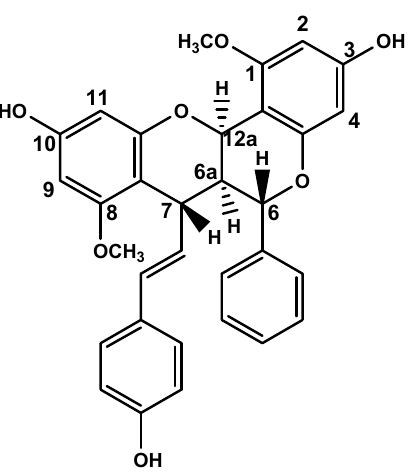
Figure 1. Chemical structure from the Brachydin A (BrA) flavonoid. The image was adapted from PubChem (CID 102339051) [14].